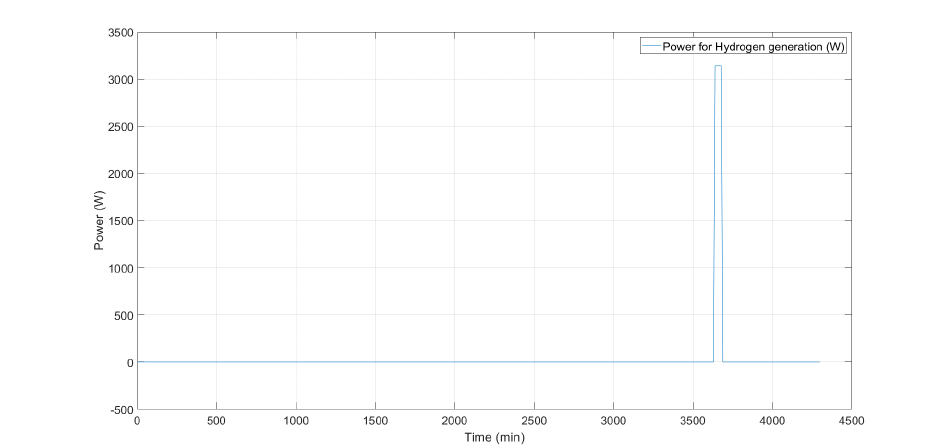
Figure 13. Evolution of the power supplied for the generation of